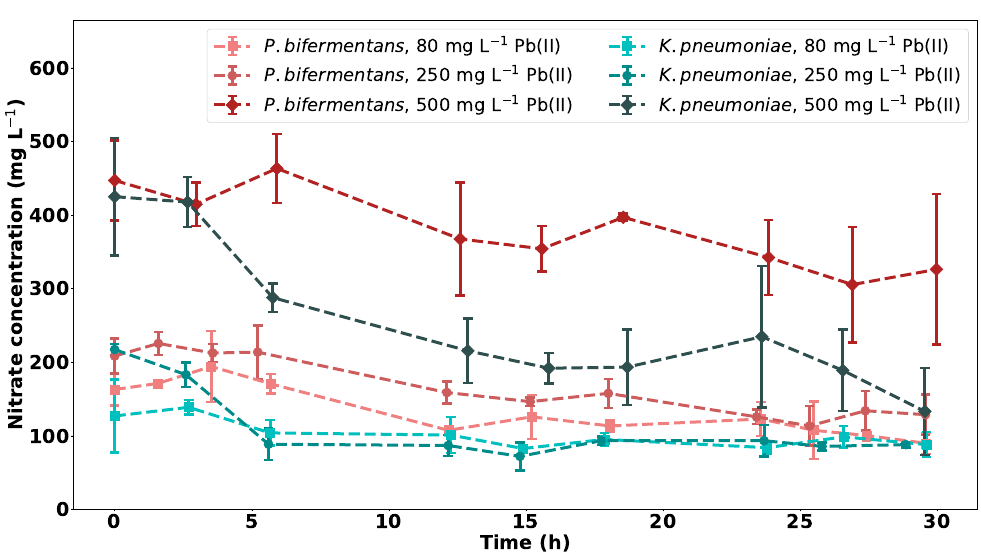
Figure 8. The nitrate concentrations over time for experiments of varying initial Pb(II) concentrations for both P. bifermentans and K. pneumoniae with n =